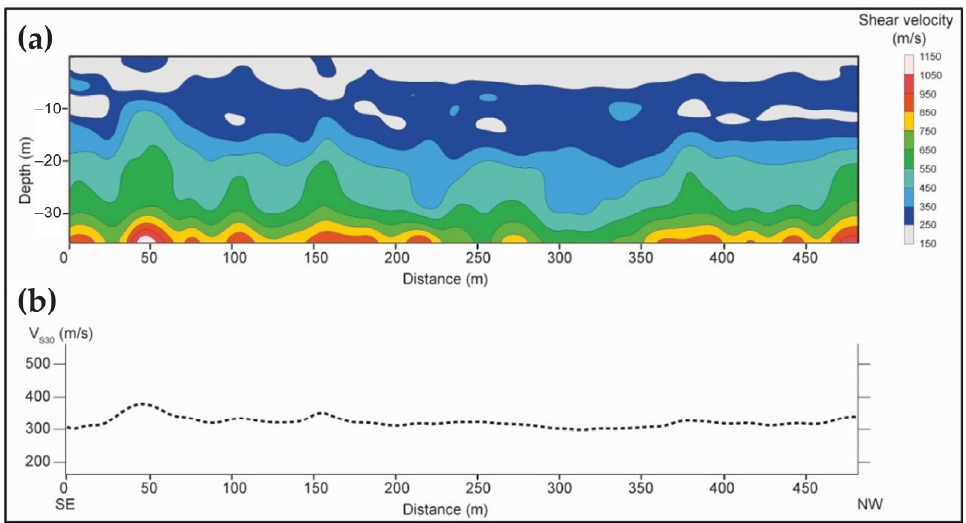
Figure 7. ( a ) MASW 2D Vs section from MASW M17 profile (Bilbao Street); ( b ) V s30 value vs. distance graph from M17 profile. Table 2. Summary of measured V s30 values with MASW technique. Additionally, the V s30 value equivalence with EC8 classification is provided, including the internal division of B ground class.